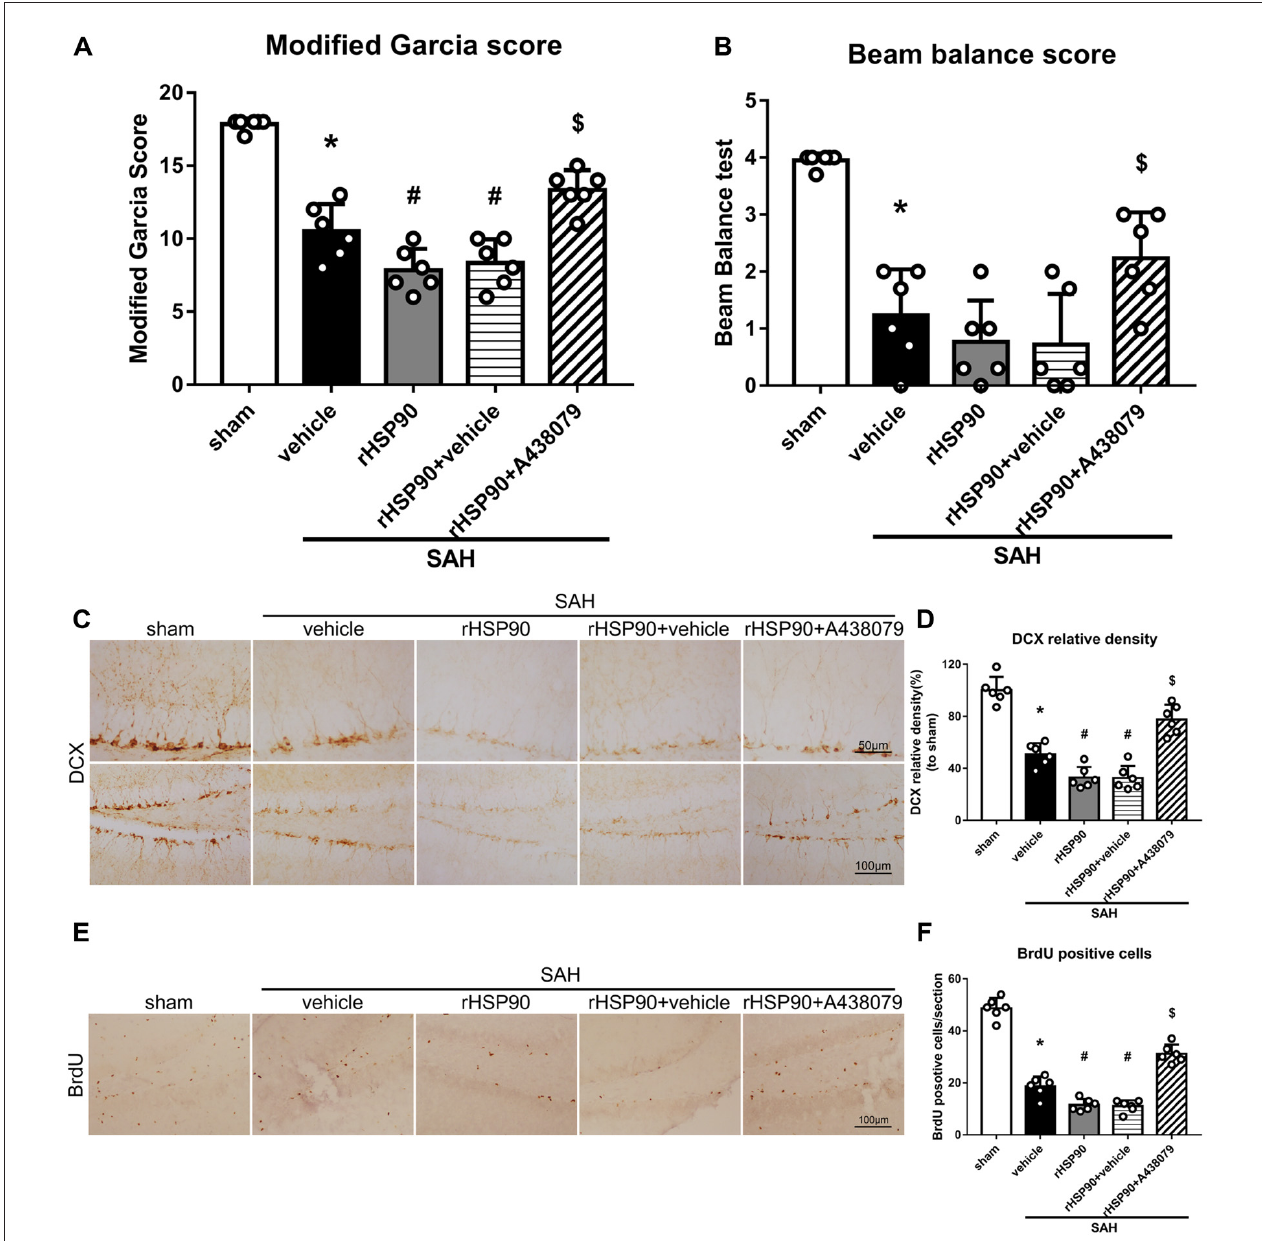
FIGURE 8 | Effects of rHSP90 and A438079 on neurobehavior and neurogenesis 48 h after SAH. (A) Modified Garcia scores and (B) beam balance test scores; n = 10 per group. (C) Immunohistochemistry staining and (D) quantitative analyses of DCX in the left hemisphere. (E) Immunohistochemistry staining and (F) quantitative analyses of BrdU in the left hemisphere; n = 4 per group. ∗ P < 0.05 vs. sham; # P < 0.05 vs. SAH + vehicle; $ P < 0.05 vs. SAH + rHSP90 + vehicle. The error bars represent